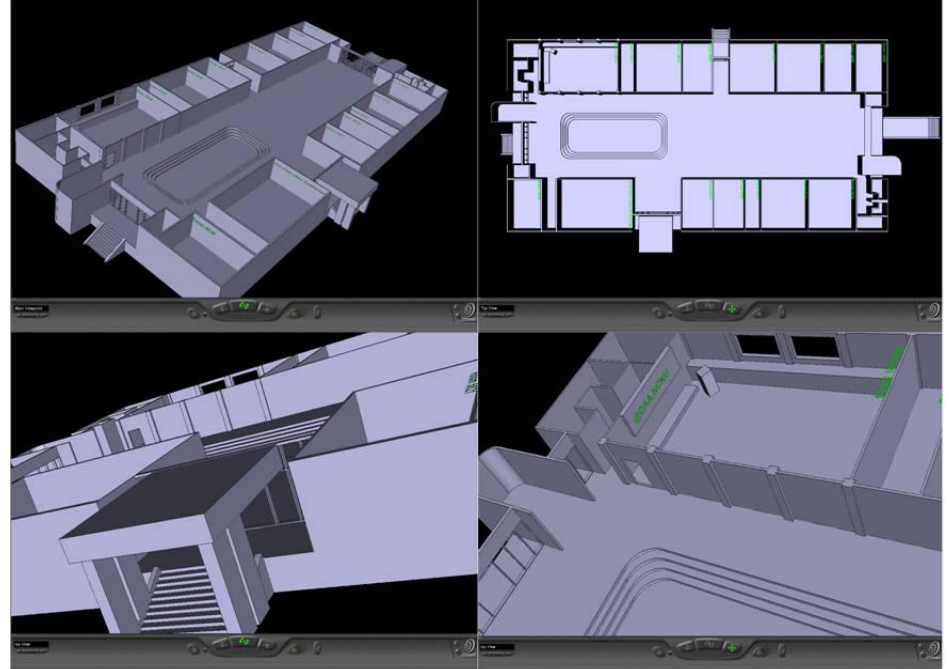
Figure 8. Snapshots of the 3D GIS of the Department of Aeronautics and Astronautics building of National Cheng Kung